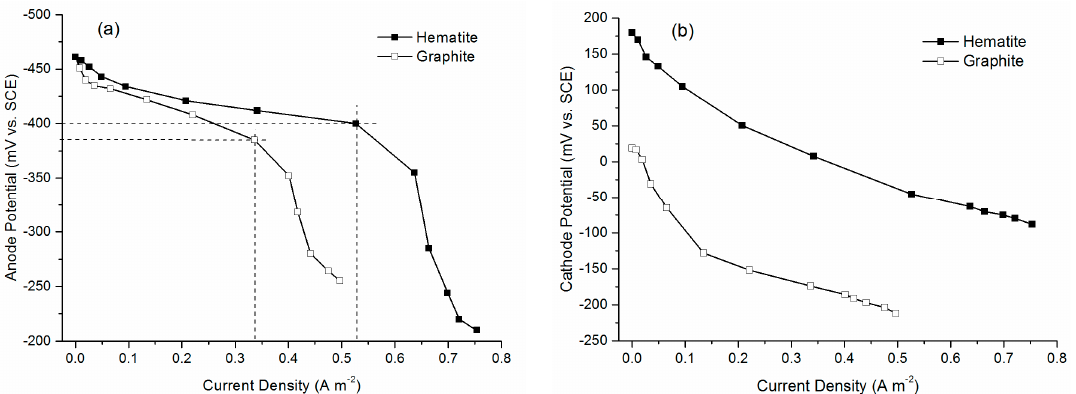
Figure 5. Potential curves with natural hematite and graphite cathodes in one typical batch cultivation of anode ( a ) and cathode ( b ).